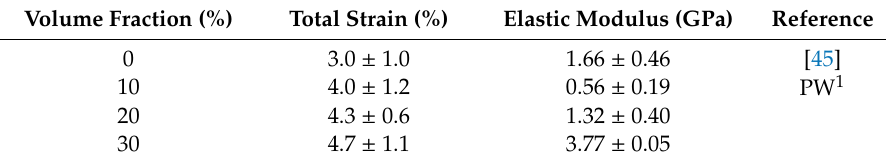
Table 8. Total strain and elastic modulus results for the CM sedge fiber-reinforced composites.